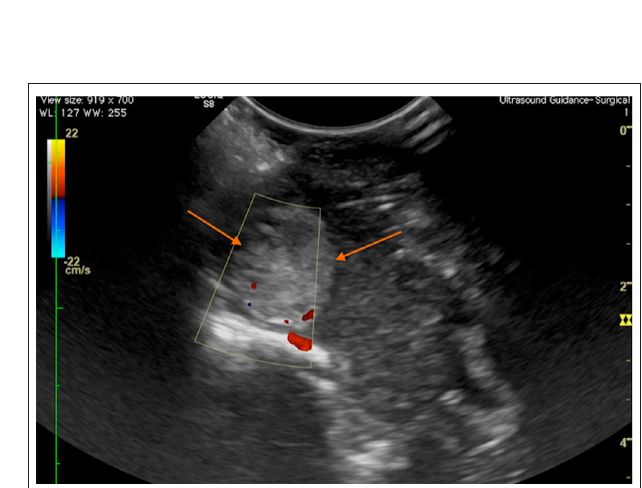
FIGURE 8 | Case 28. Transverse intraoperative ultrasound view of a frontal meningioma (arrows) in a canine patient. The Doppler shows that the major arterial blood supply to the mass is at the ventral aspect, in the area of the floor of the calvarium.